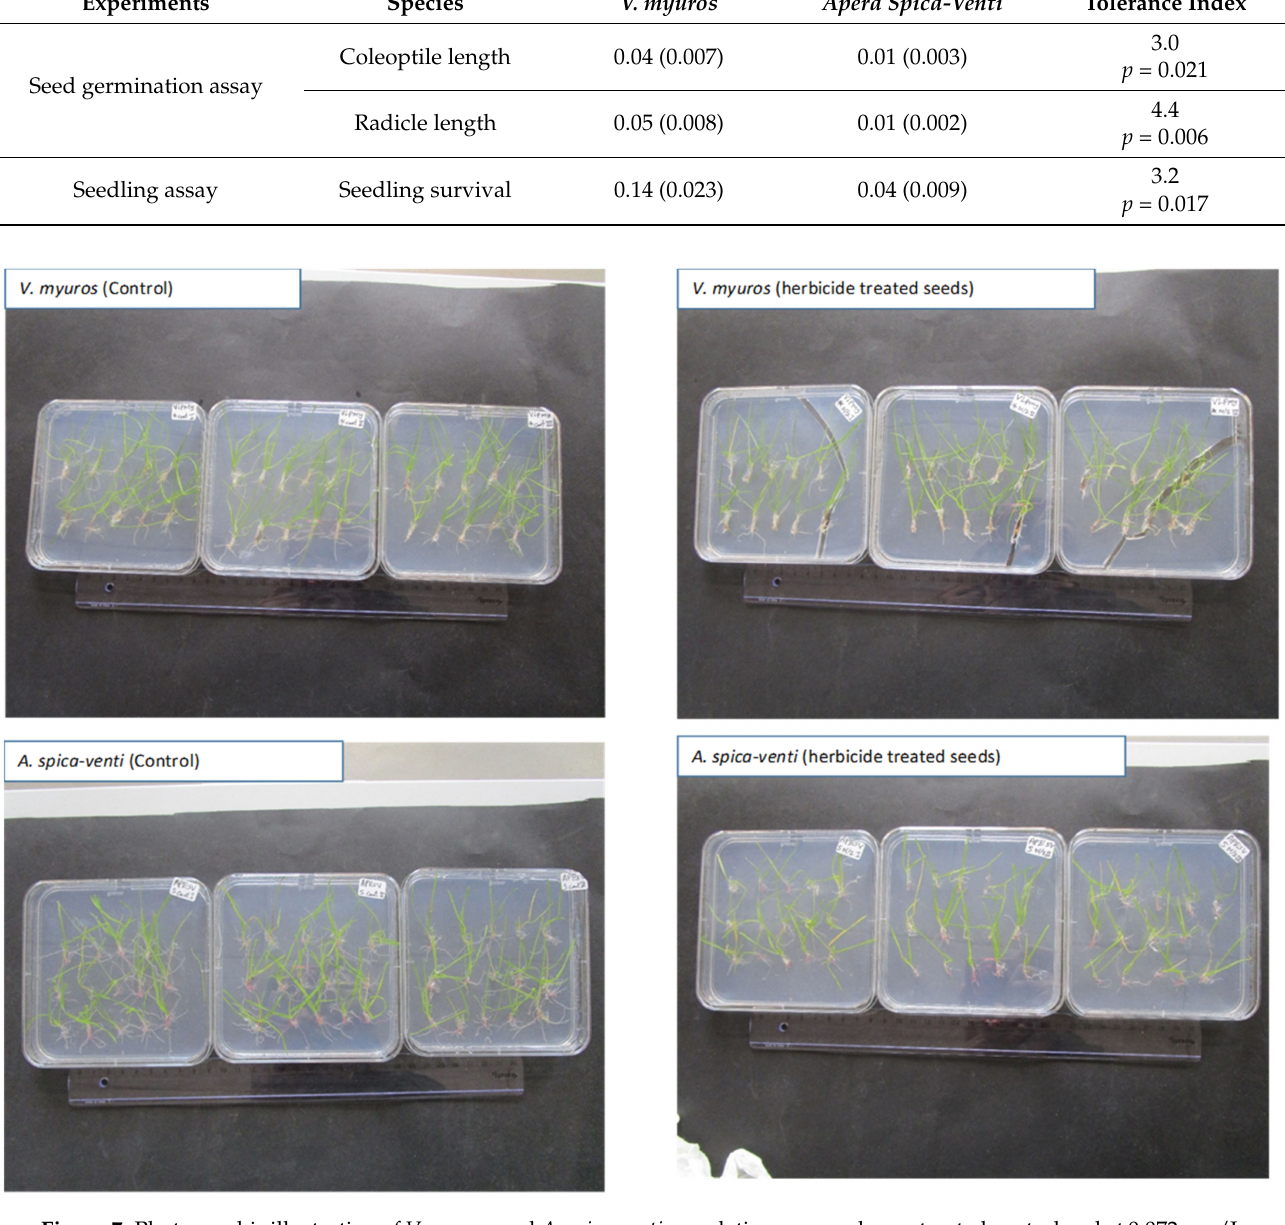
Figure 7. Photographic illustration of V. myuros and A. spica-venti populations assayed as untreated control and at 0.072 mg/L mesosulfuron + iodosulfuron in the agar-based seedling